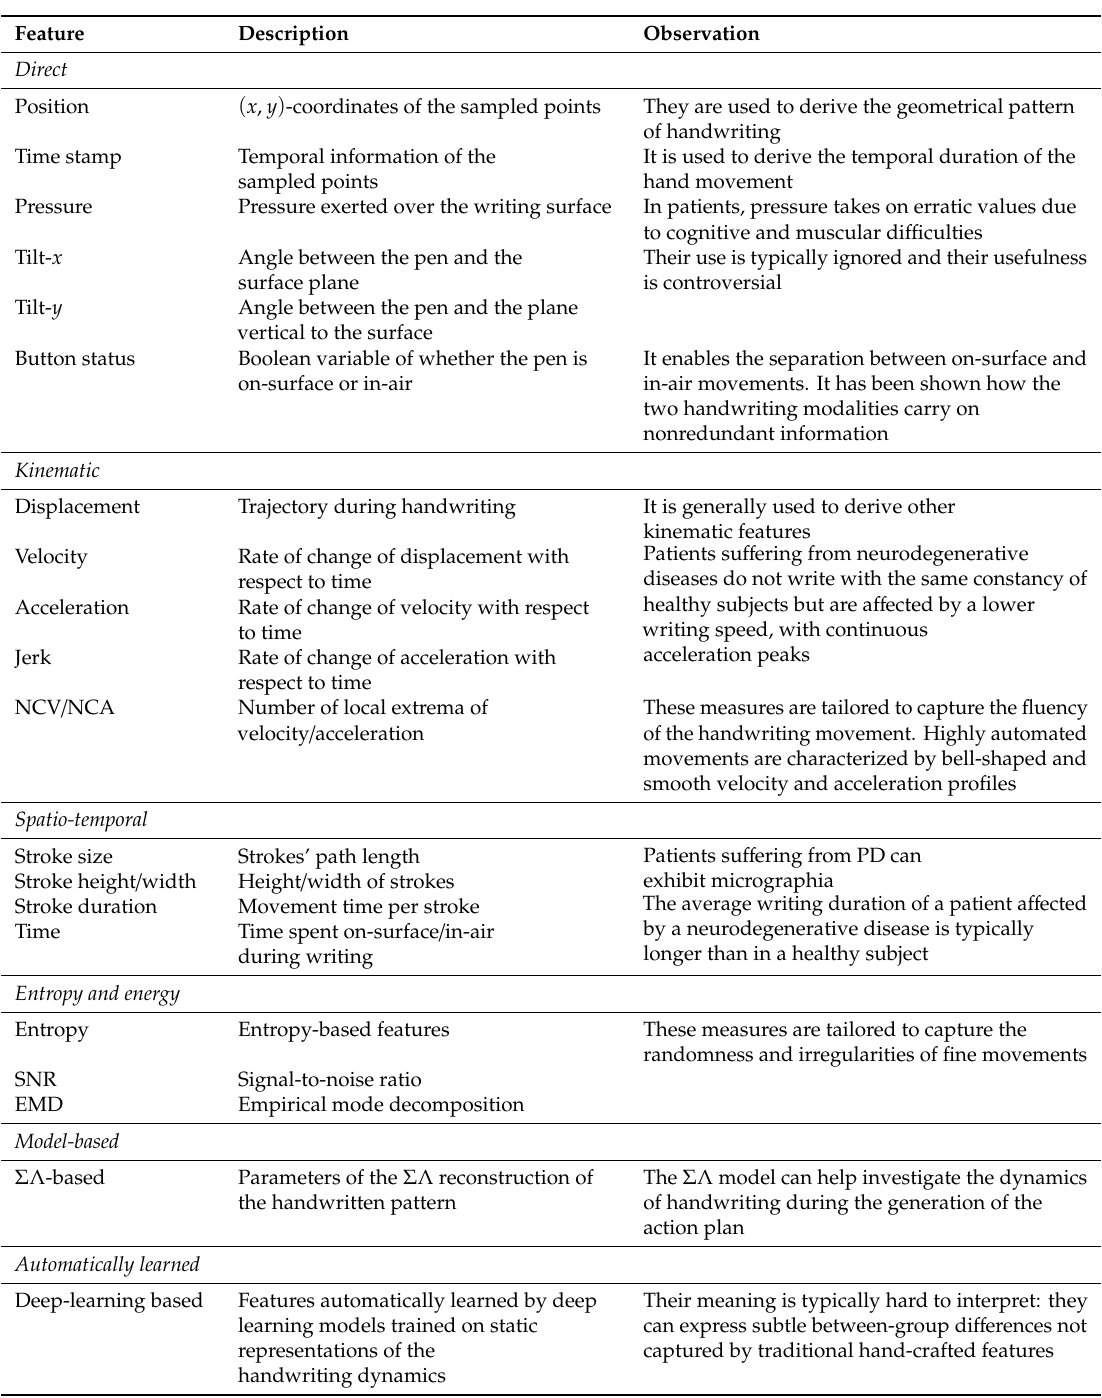
Table 2. Most commonly used features: they are typically intended both on-surface and